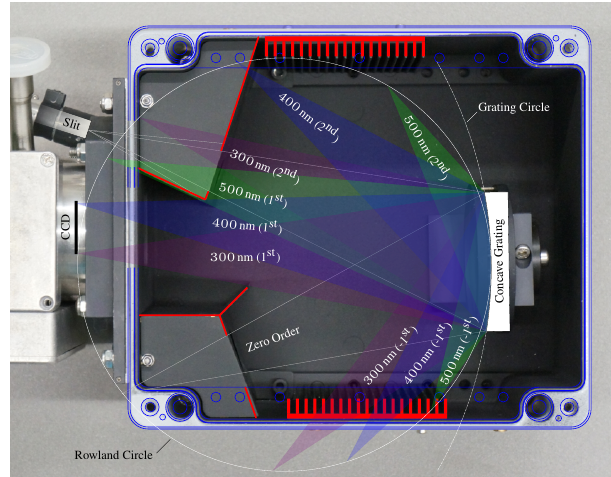
Figure 7. Opened HAIDI imaging spectrograph showing the diffraction angles of the grating for different wavelengths (300nm (violet), 400nm (blue), 500nm (green)) and orders. Due to the con- cave grating the spectrograph works on the basis of the Rowland cir- cle. For an optimized imaging on flat surfaces (e.g., CCD) the shape of the Rowland circle is slightly altered by a special groove pattern of the grating (flat-field correction). This is why the entrance slit is not located exactly on the illustrated circle. Installed light traps are marked in